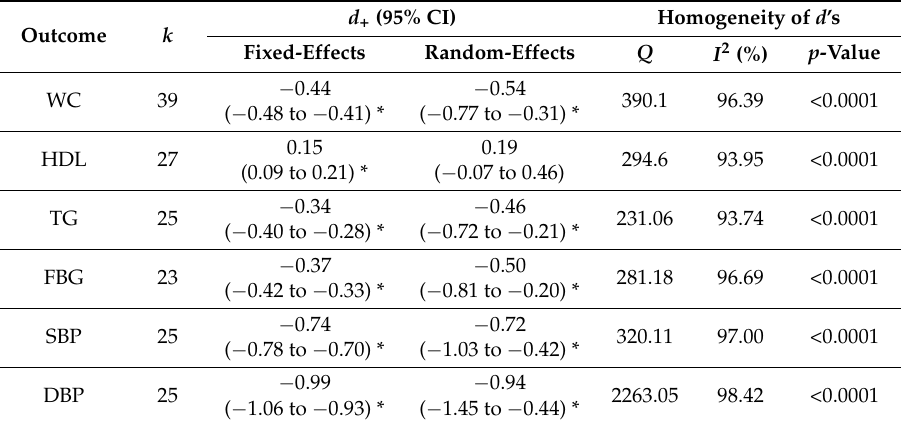
Table 2. Summary of Results, Overall Effect Sizes and